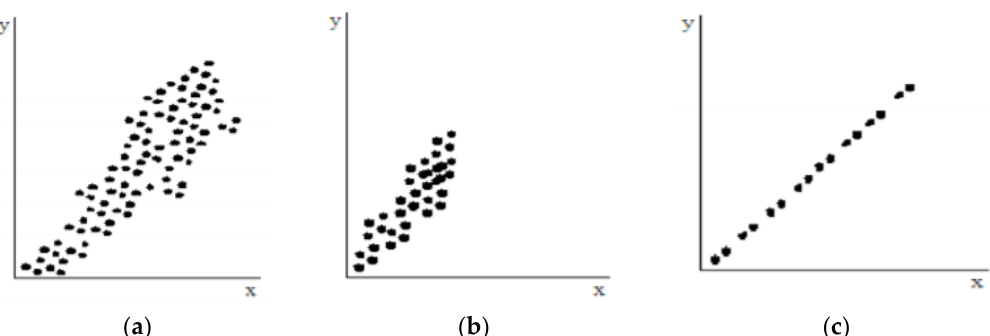
Figure 1. The positive correlation of a ( a ) directly proportional correlation, ( b ) strong directly proportional correlation, and ( c ) completely directly correlation.